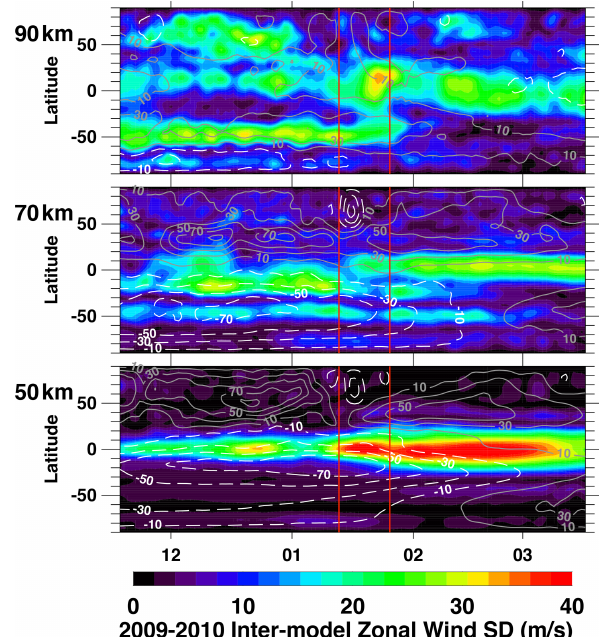
Figure 11. As in Fig. 10 but for zonal wind standard deviation among the analyses. For reference, dashed white and solid gray con- tours indicate the mean easterly and westerly winds, respectively, among the data sets. Contours are drawn every 20ms − 1